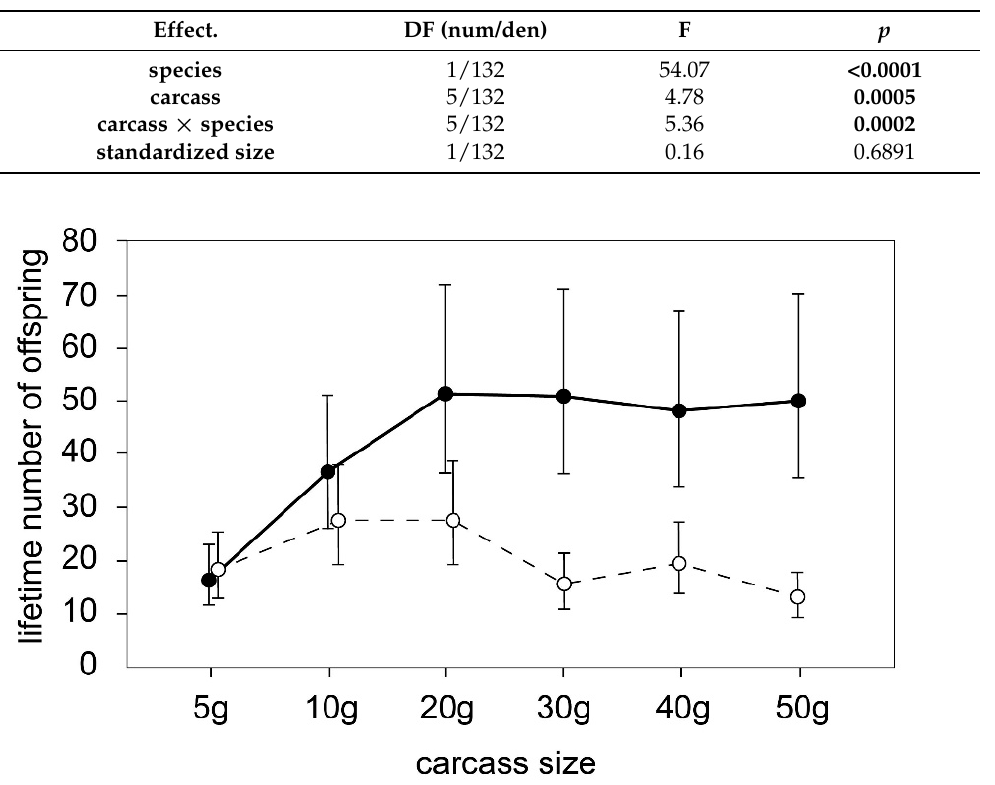
Figure 1. Mean lifetime number of offspring (error bars are 95% confidence interval) produced by N. marginatus (solid circle and line) and N. guttula (open circles and dashed line) across six carcass sizes.